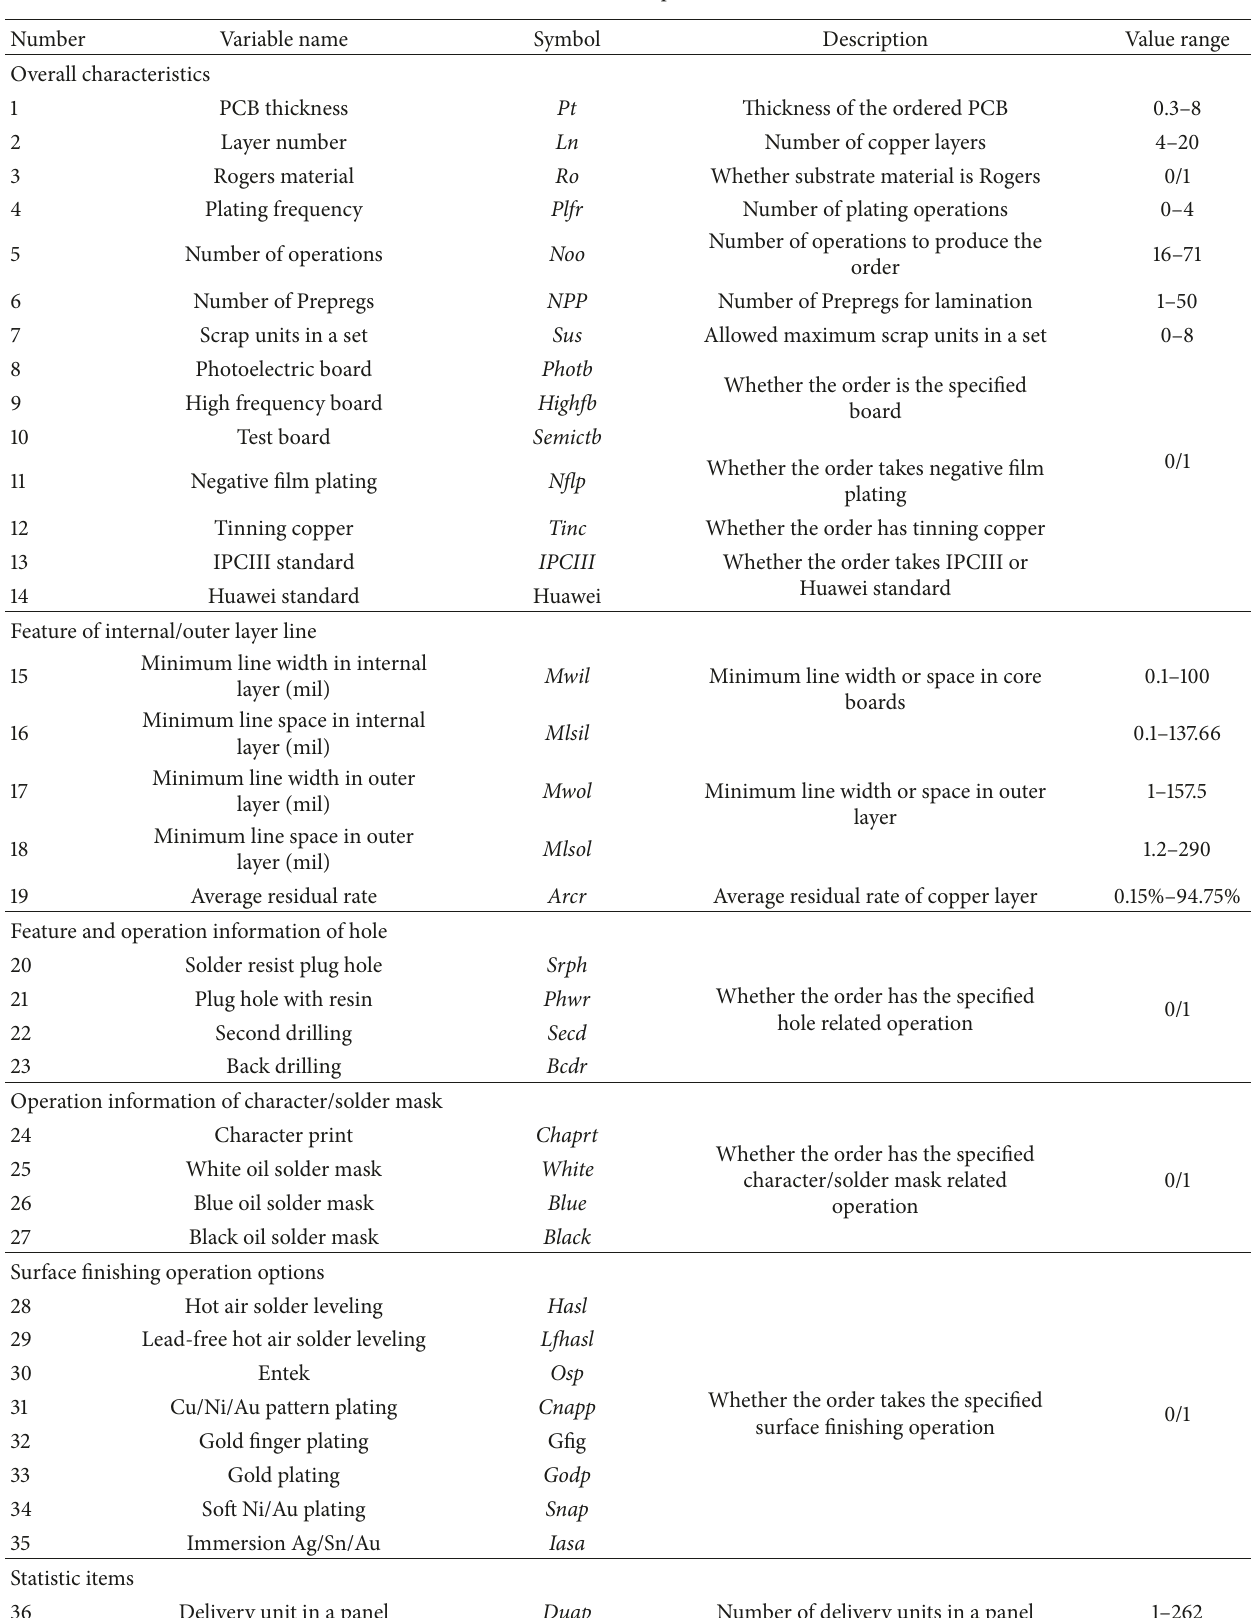
Table 1: Variables